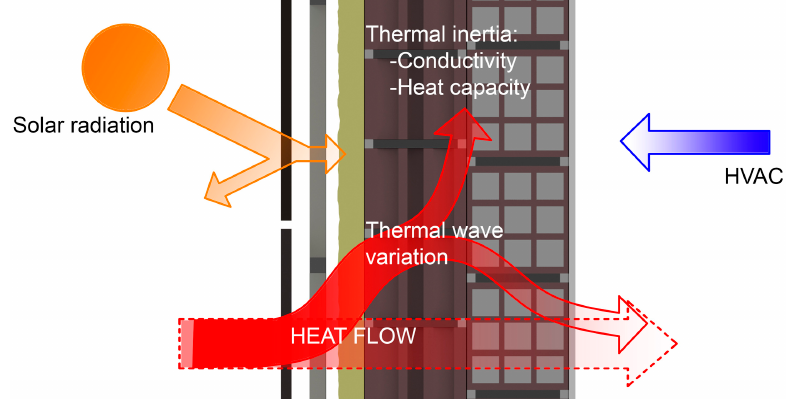
Figure 1. The dynamic process of heat transmission through enclosures.